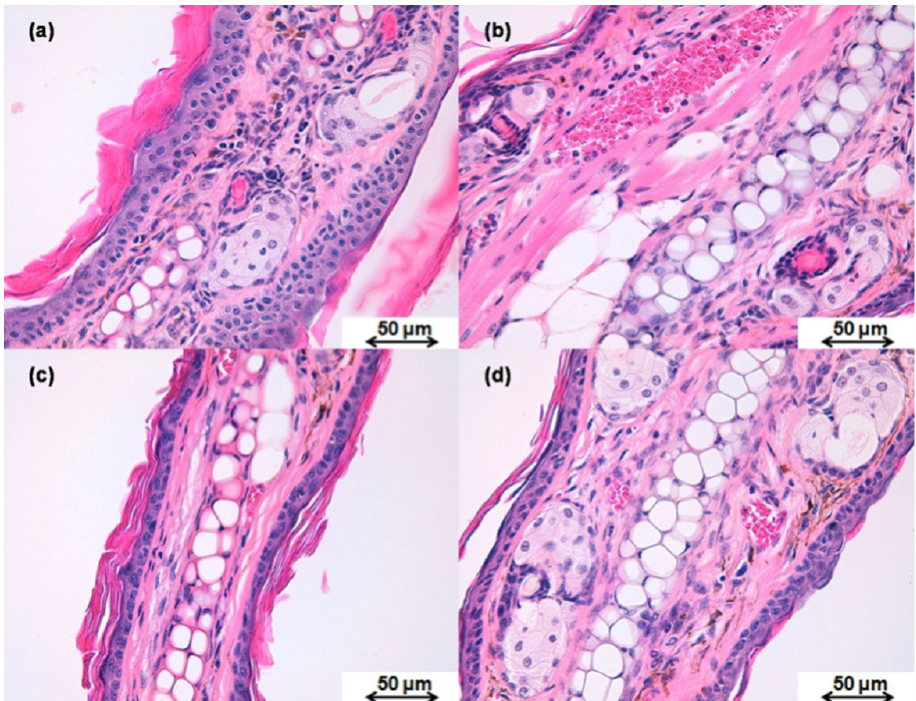
Figure 7. Histological images of the mice ear after the TPA-induced ear oedema in mice. ( a ) negative control ear; ( b ) positive control ear; ( c ) ear treated with KT-NPs, and ( d ) ear treated with KT-CTS gel. The scale bar is 50 µm in length. The small purple cells corresponding to the immune system cells.